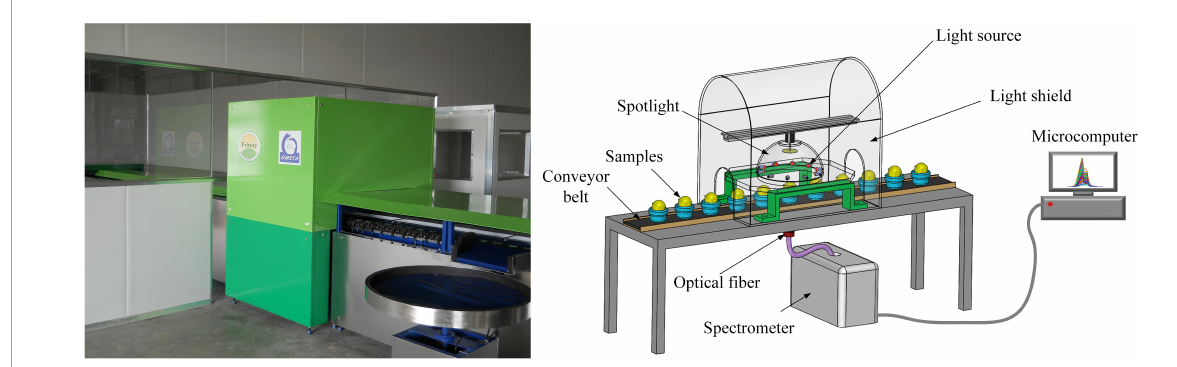
FIGURE1 Schematic diagram of the Vis-NIR online sorting device for Yali pears.